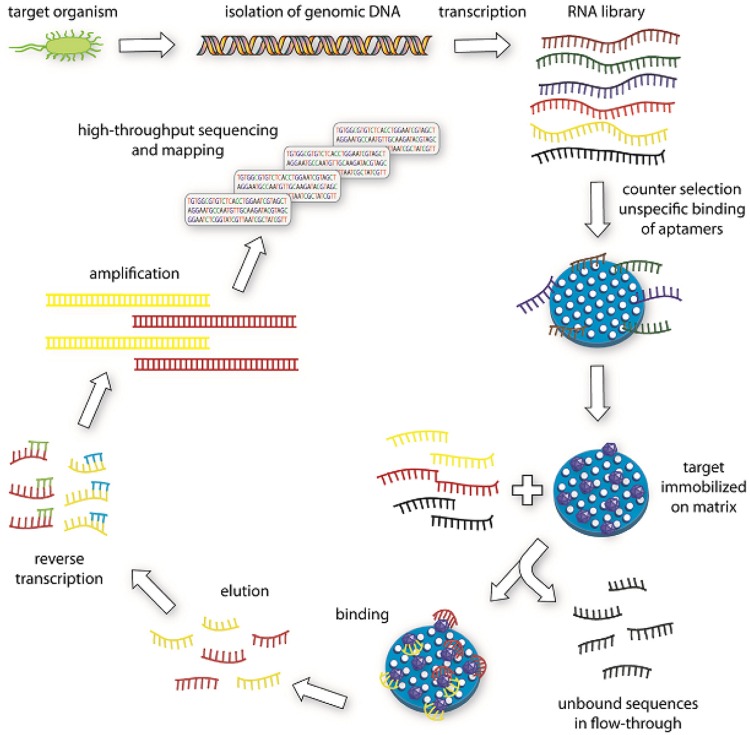
Illustration of genomic SELEX (Lorenz et al., 2010). Genomic DNA is isolated from the target organism.